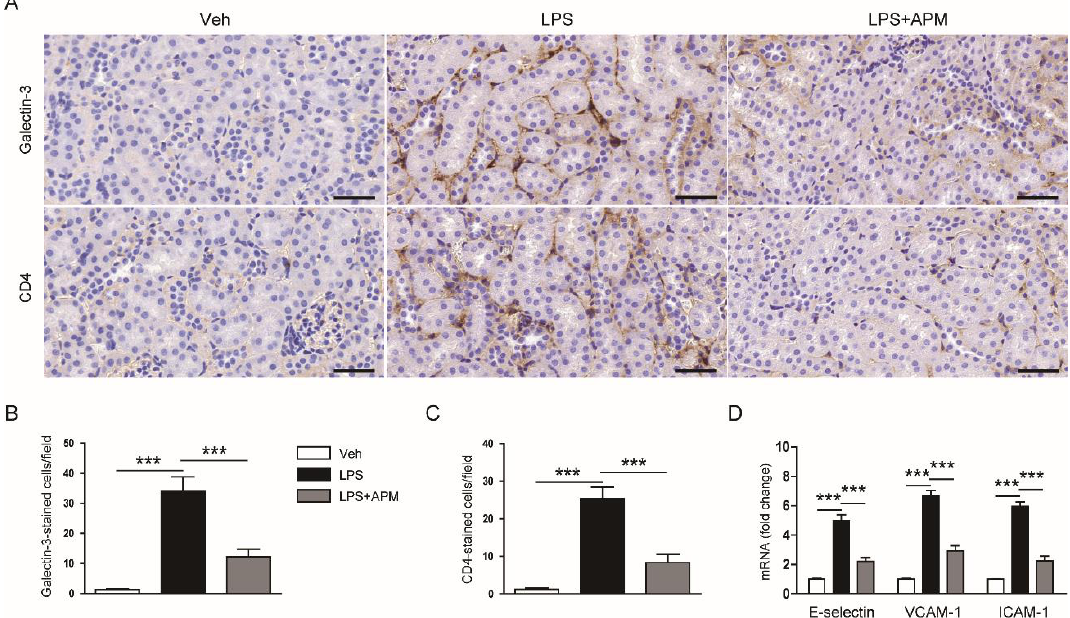
Figure 9. Effect of apamin on immune cell accumulation and expression of vascular adhesion molecules in LPS-injected mice. ( A ) Immunohiotochemical staining of kidney tissues for galectin-3 or CD4. Scale bars: 20 μm. ( B ) Number of galectin-3-stained cells. ( C ) Number of CD4-stained cells. ( D ) The mRNA expression of E-selectin, vascular cell adhesion molecule-1 (VCAM-1), and intercellular adhesion molecule-1 (ICAM-1). n = 8 per each group. *** p <